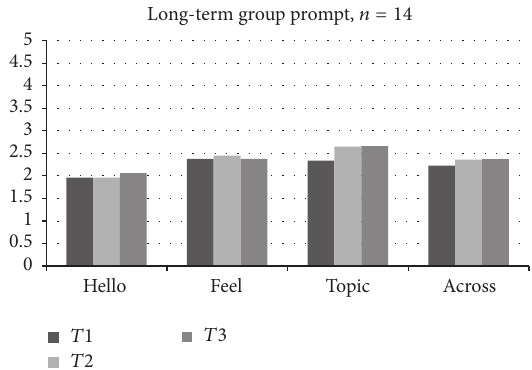
Figure 1: Long-term group response across time points.